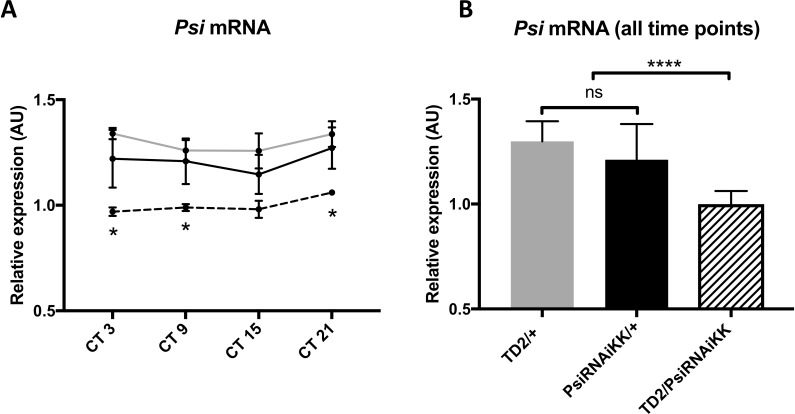
Psi mRNA expression does not cycle and its level is reduced in heads of Psi knockdown flies.(A) Psi mRNA expression does not cycle in DD. Relative expression of Psi mRNA (normalized to the average of all Psi knockdown time points) in heads on the y axis measured by qPCR. Circadian time (CT) on the x axis. Error bars represent SEM. Gray line: driver control. Black line: RNAi control. Dashed line: Psi knockdown. Controls, N = 3. Psi knockdown, N = 5. Both driver and RNAi control relative to Psi knockdown, two-way ANOVA followed by Tukey’s multiple comparison test: *p<0.05. (B) Knockdown of Psi with RNAiKK causes a significant reduction in Psi mRNA levels relative to both driver and RNAi controls. Since no cycling of Psi was observed, all time points were pooled to increase statistical strength. Relative expression of Psi mRNA (normalized to the average of all Psi knockdown time points) in heads on the y axis measured by qPCR. Genotypes are on the x axis. Error bars represent SEM. Gray bar: driver control. Black bar: RNAi control. Patterned bar: Psi knockdown. Both driver and RNAi control relative to Psi knockdown, one-way ANOVA followed by Tukey’s multiple comparison test: ****p<0.0001.Figure 2—figure supplement 1—source data 1.Psi qPCR data.Figure 2—figure supplement 1—source data 2.Figure statistics – Figure 2—figure supplement 1.